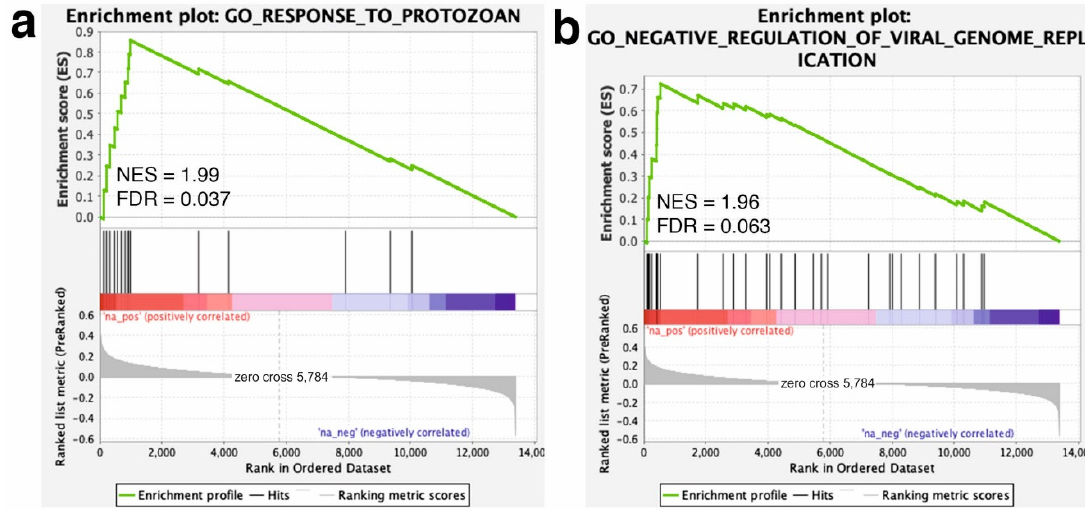
Figure 3. Gene set enrichment analysis (GSEA) plot (score curves) for enriched biological processes. The GSEA analysis was performed with the biological process gene sets of GSEA Molecular Signatures Database. The “Signal-to-Noise” ratio (SNR) statistic was used to rank the genes per their correlation with the dietary GP supplementation (red) or the un-supplemented CTR phenotype (blue). The heatmap on the right side of each panel visualize the genes mostly contributing to the enriched gene set. For the fully detailed list, see Supplementary Table S3. The green curve corresponds to the Enrichment Score (ES) curve, which is the running sum of the weighed ES obtained from the GSEA software, while the Normalized Enrichment Score (NES) and the corresponding p -value are reported within each graph. Panels ( a , b ) denote the most enriched (significant) biological processes (i.e., gene sets).